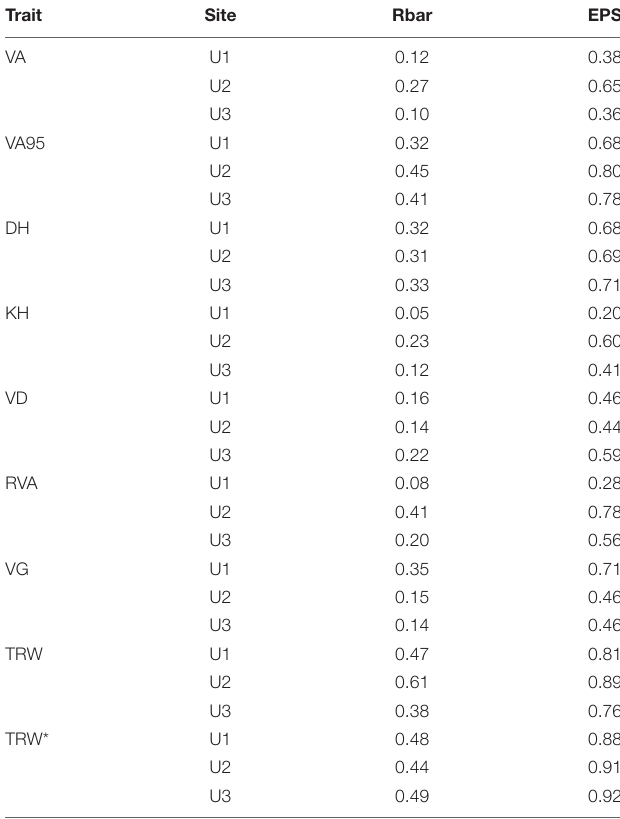
TABLE 2 | Descriptive statistics of the different wood anatomical chronologies at each site. Rbar–mean inter-series correlation; EPS–expressed population signal. Period 1968–2004 ( n = 5). For anatomical trait abbreviations, see Figure 2